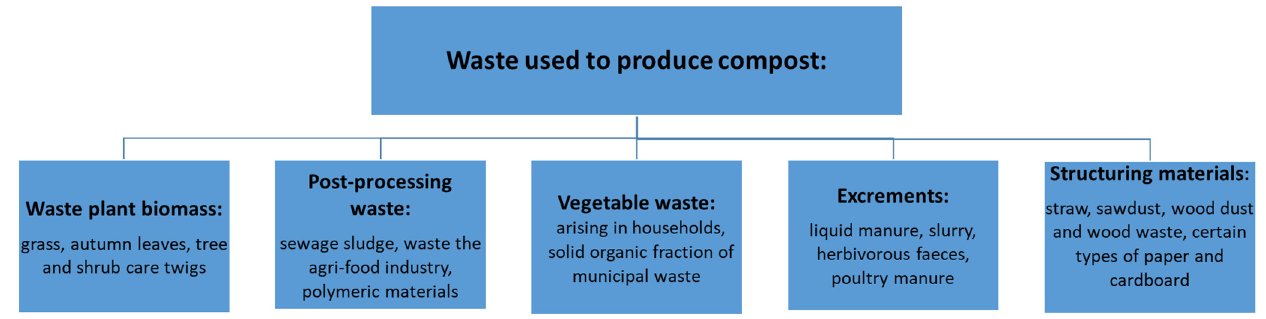
Figure 2. The use (as % of total mass) of sewage sludge for reclamation purposes between years of 2000 and 2019, performed their own study based on Statistics Poland data, (https://stat.gov.pl/en, accessed on 28 November 2021) [16].